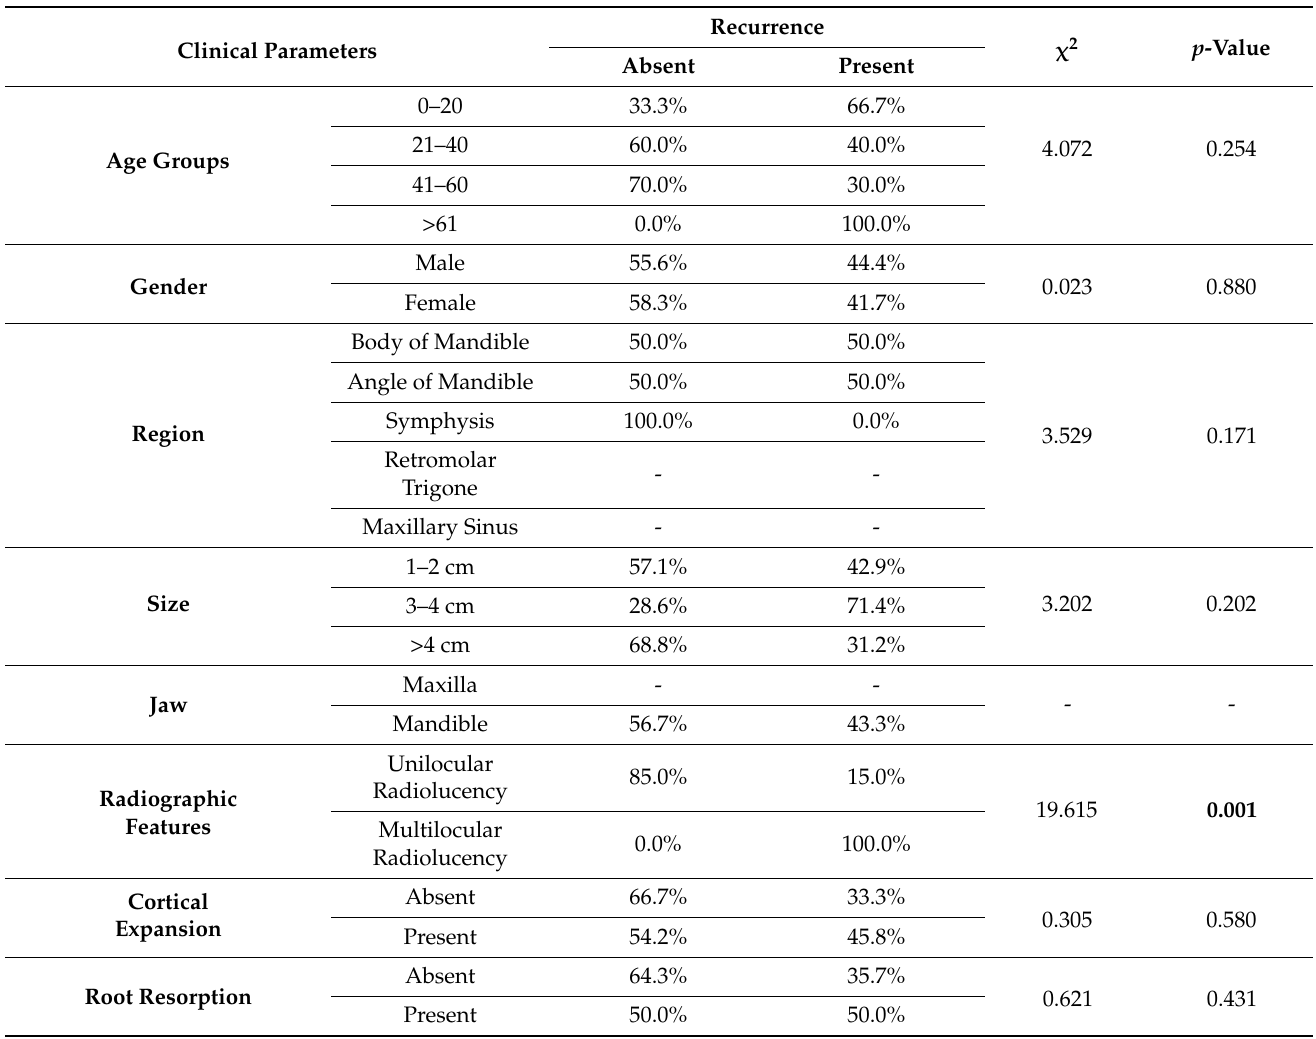
Table 4. Comparison of correlation of clinical parameter with recurrence of unicystic ameloblastoma— UA-mural